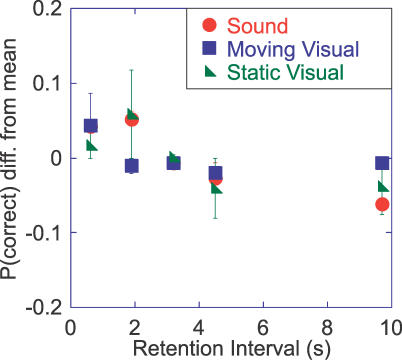
Effect of Retention IntervalDifference from mean proportion correct responses (P(correct) diff) is plotted as a function of the retention interval. Proportion correct decreases modestly with retention intervals up to 9.7 s. The mean proportions correct subtracted for each stimulus type were: sound, 0.77; moving visual, 0.66; and stationary visual, 0.62.